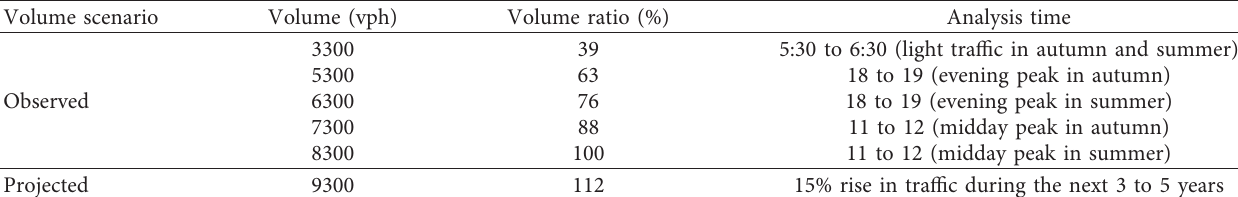
Figure 2: (a) Basij intersection in SCATS; (b) phasing of Table 2: Traffic volume scenarios.